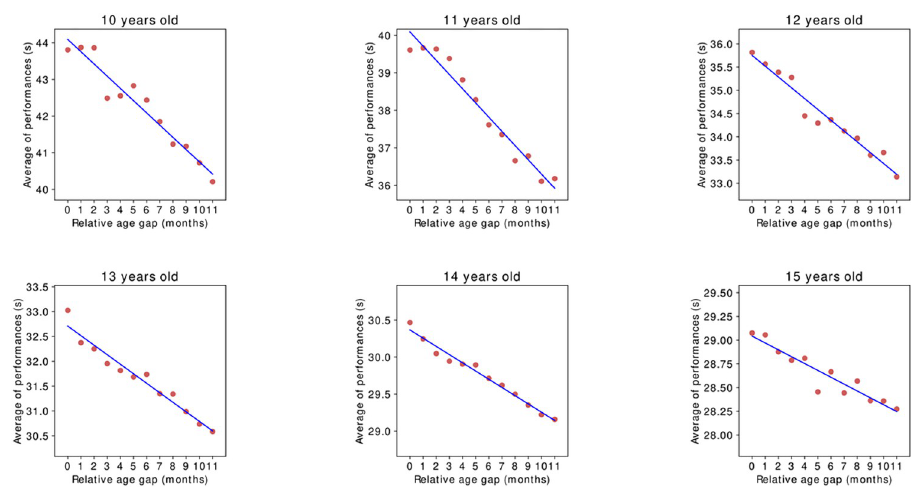
Fig 1. Performance means and relative age gap by age on 50m Freestyle male swimmers in 50m pools for 10-years- old to 15-years-old categories .